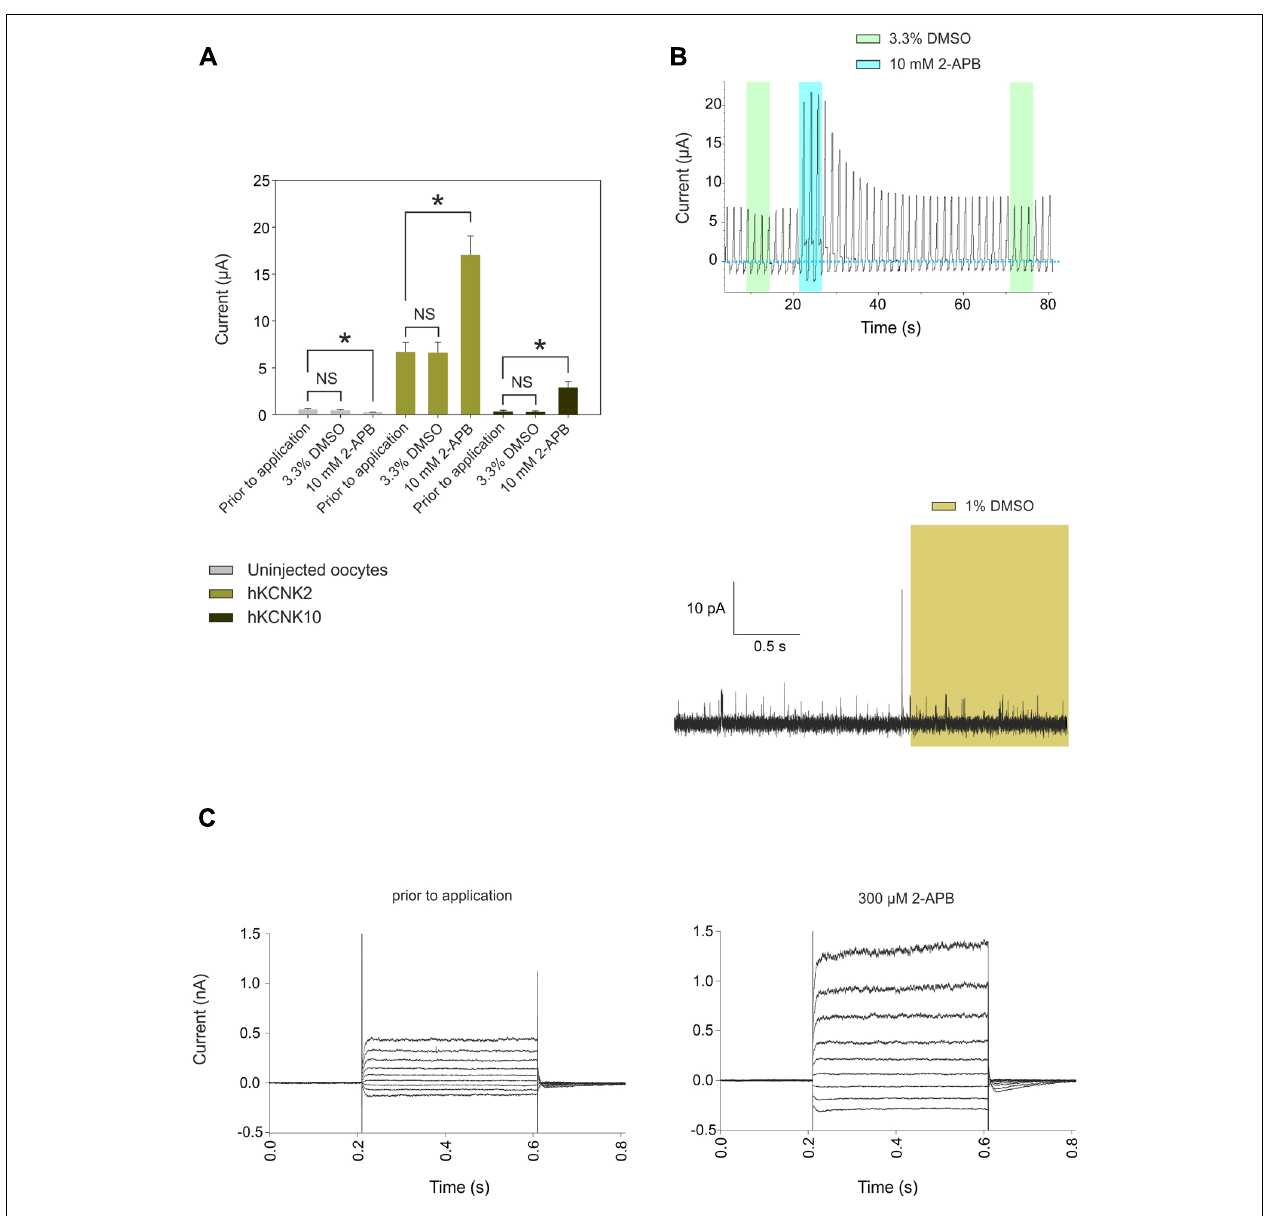
10 mM DMSO (blue rectangles). Bottom: Representative voltage clamp recording from an inside-out patch-clamp of a HEK293 cell expressing hKCNK10, before and after exposure to 1% DMSO (light green rectangle). (C) hKCNK4 currents recorded from a transfected HEK293 cell before (right) and after (left) the application of 300 μ M 2-APB. Currents were elicited by voltage pulses from − 110 to + 50 mV in 20 mV steps, 400 ms in duration, from a holding potential of − 60